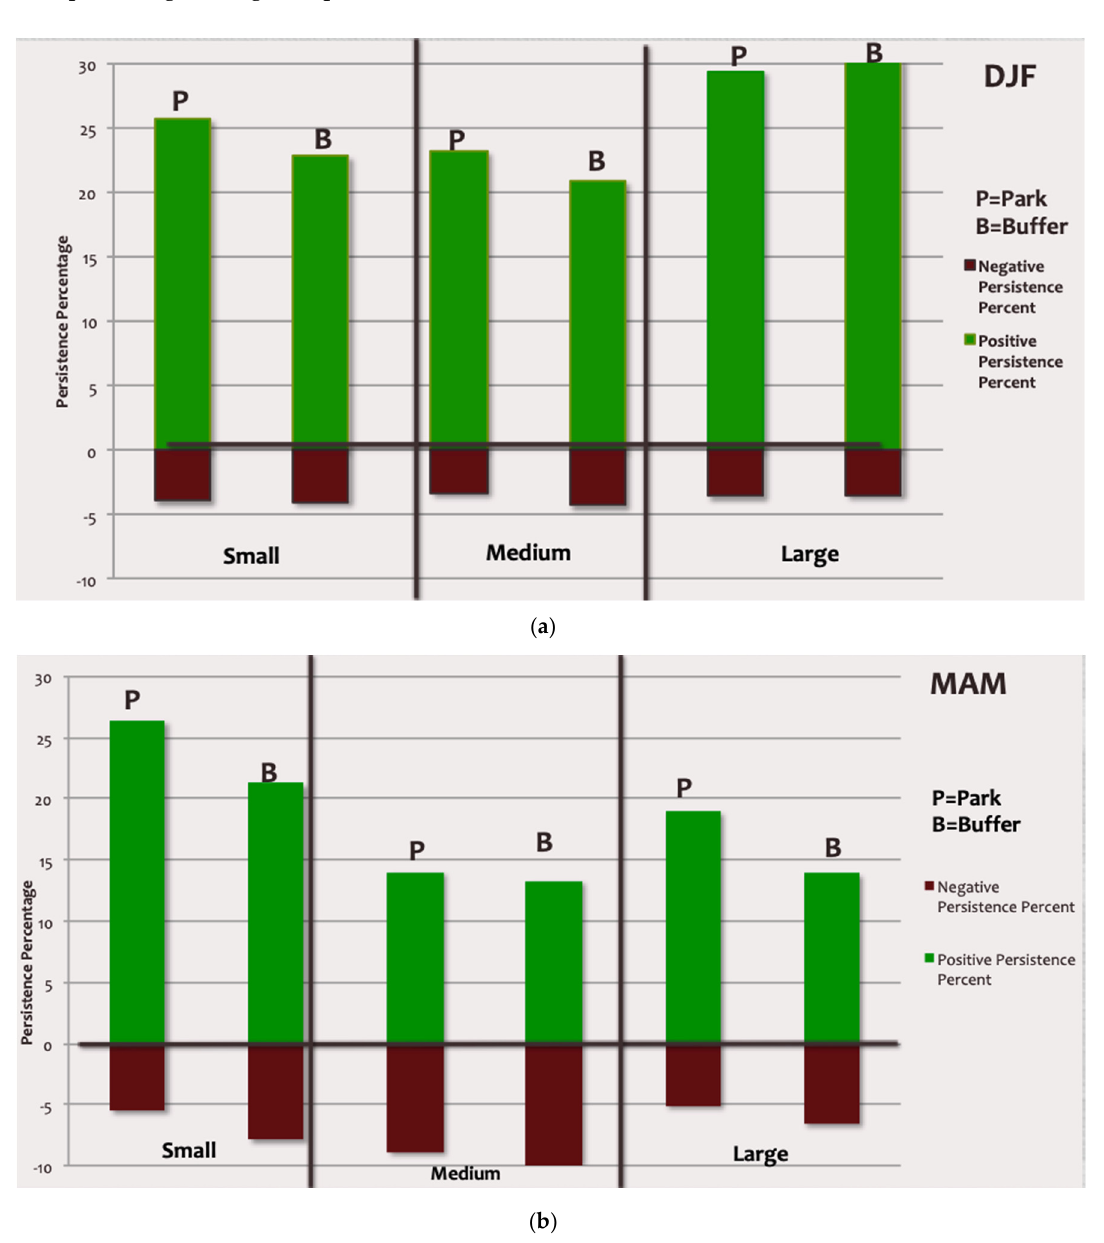
Figure 4. Percentage of significant positive and negative directional persistence values across small, medium, and large parks and buffers in (a) December, January, February and (b) March, April, May.